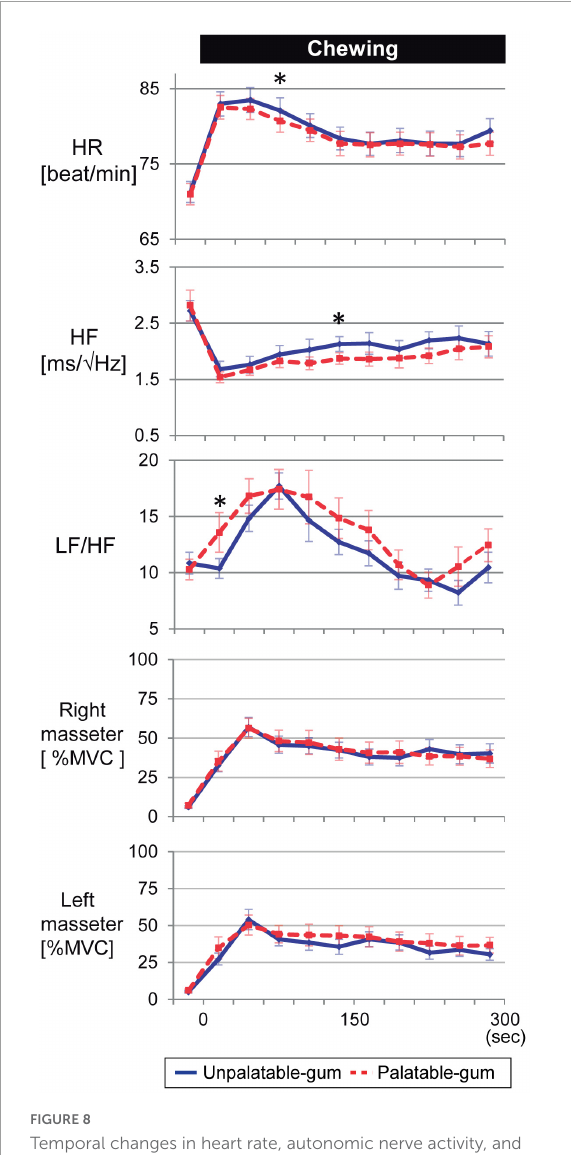
FIGURE8 Temporal changes in heart rate, autonomic nerve activity, and bilateral masseter muscle activity for every 30 s of gum chewing. ∗ Indicates a significant difference between palatable and unpalatable gums. Blue line: unpalatable gum. Red line: palatable gum. A repeated analysis of variance was performed to investigate changes in each index between baseline (median value for 5 min before chewing started) and each 30-s interval after the start of chewing. If a difference was significant, comparisons were made between values before gum chewing and those at other intervals using Dunnett’s